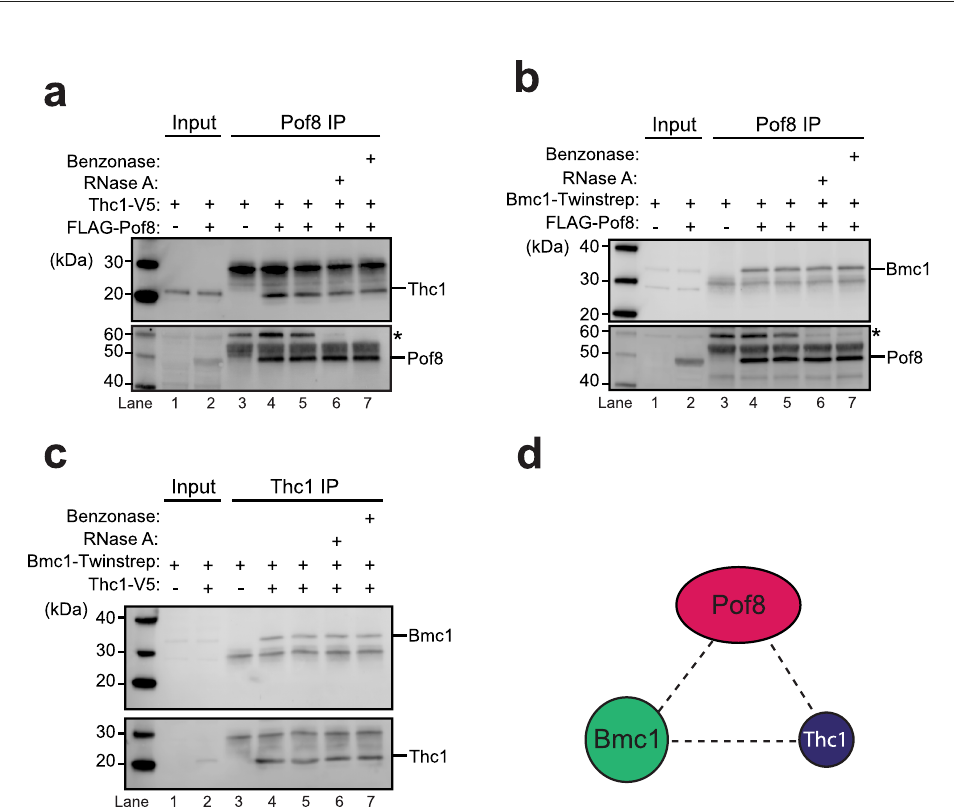
Fig. 2 Associations between Pof8, Thc1, and Bmc1. a Thc1 co-immunoprecipitates with Pof8. Co-IP of Thc1-2xV5 with 3xFLAG-tagged or untagged Pof8 by anti-FLAG. Western blot for input (10%, lanes 1 and 2) and IP (lanes 3 – 7) probed with anti-V5 to detect Thc1-2xV5 ( top ) and reprobed with anti-FLAG for 3xFLAG-Pof8 ( bottom ). Samples in lanes 5 – 7 were incubated at 37°C for 15min to assess whether the interactions are mediated by nucleic acid. An asterisk marks a protein of approximately 60kDa that is recognized by the FLAG antibody even in cells that lack FLAG-tagged Pof8 (lane 3). This 60kDa protein of unknown identity is enriched in the immunoprecipitate in an RNA-dependent, but FLAG-Pof8 independent manner. b Bmc1 co-immunoprecipitates with Pof8. IP with anti-FLAG in extracts from strains harboring Twinstrep-tagged Bmc1 and 3xFLAG-tagged or untagged Pof8. Plus indicates the presence of the tag. Western blot for input (10%, lanes 1 and 2) and IP (lanes 3 – 7) probed with anti-strep-tag II for Bmc1-Twinstrep (top) and reprobed with anti-FLAG for 3xFLAG-Pof8 (bottom). Samples in lanes 5 – 7 were treated as in a . Asterisk marks the same non-speci fi c band as described in a . c Bmc1 co-immunoprecipitates with Thc1. Co-IP of Twinstrep-tagged Bmc1 with 2xV5-tagged or untagged Thc1. Western blot for input (10%, lanes 1 and 2) and immunoprecipitated (lanes 3 – 7) probed with anti- strep-tag II for Bmc1-Twinstrep (top) and anti-V5 for Thc1-2xV5 (bottom). Samples in lanes 5 – 7 were treated the same way as in a . d Schematic of interactions among the three